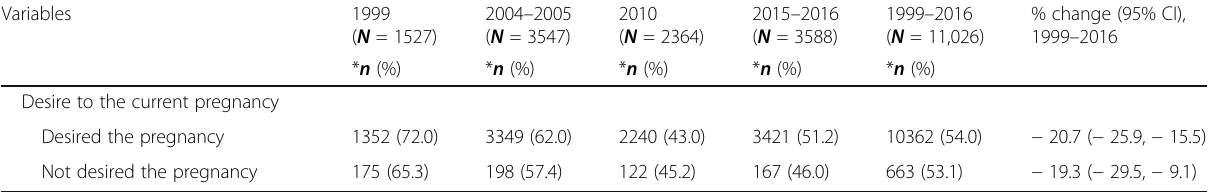
Table 3 Prevalence of four or more antenatal care visits by the study factors in Tanzania, 1999 – 2016 (Continued)